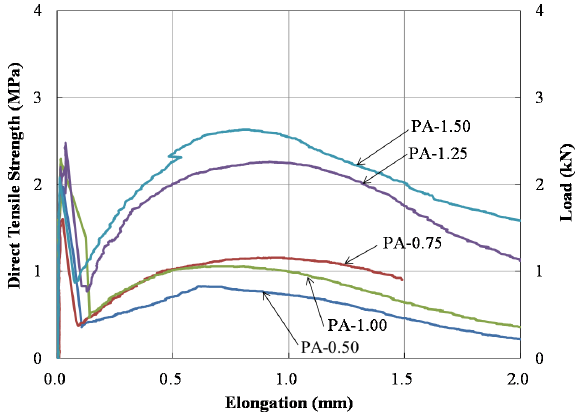
Figure 4. Direct tensile test results.